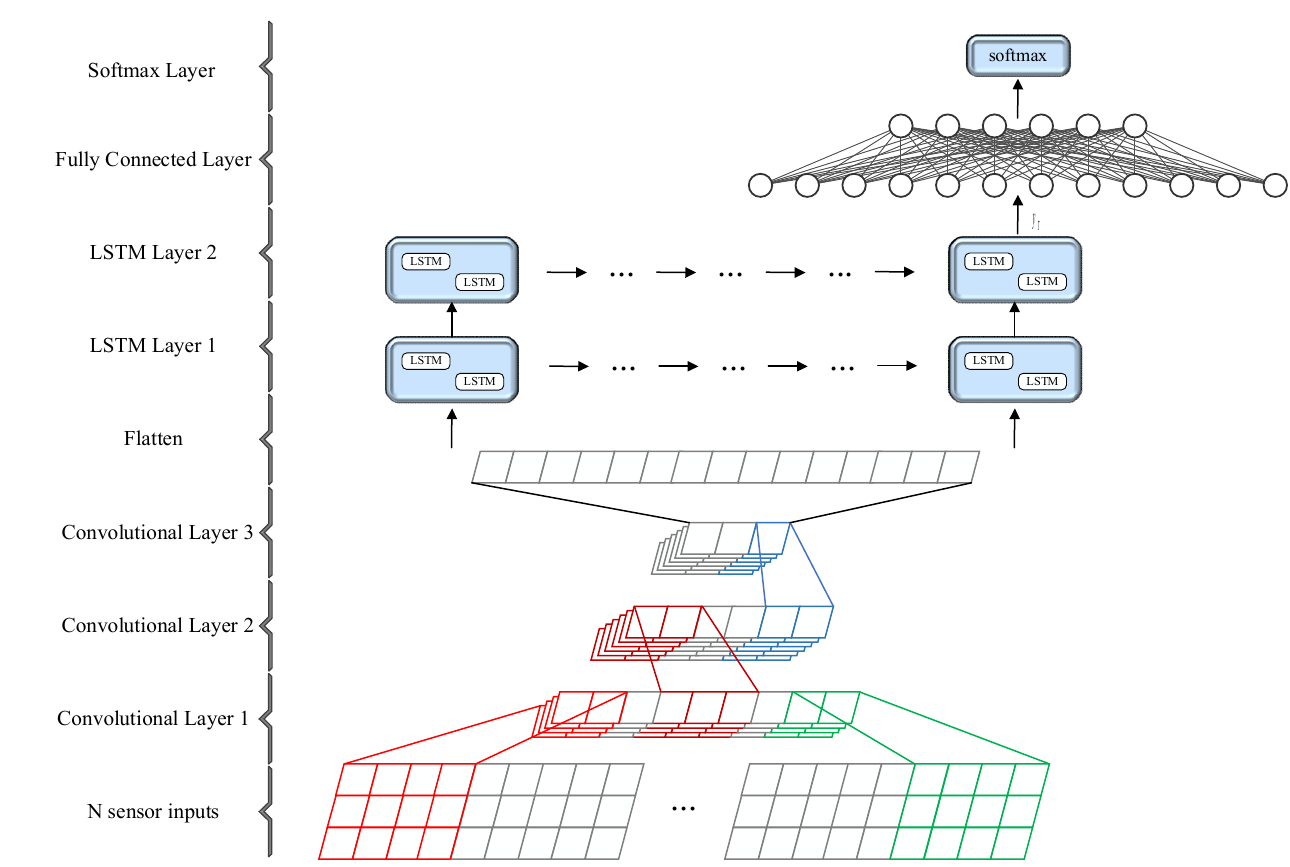
Figure 4. Main architecture of the proposed SConvLSTM network for human activity recognition.